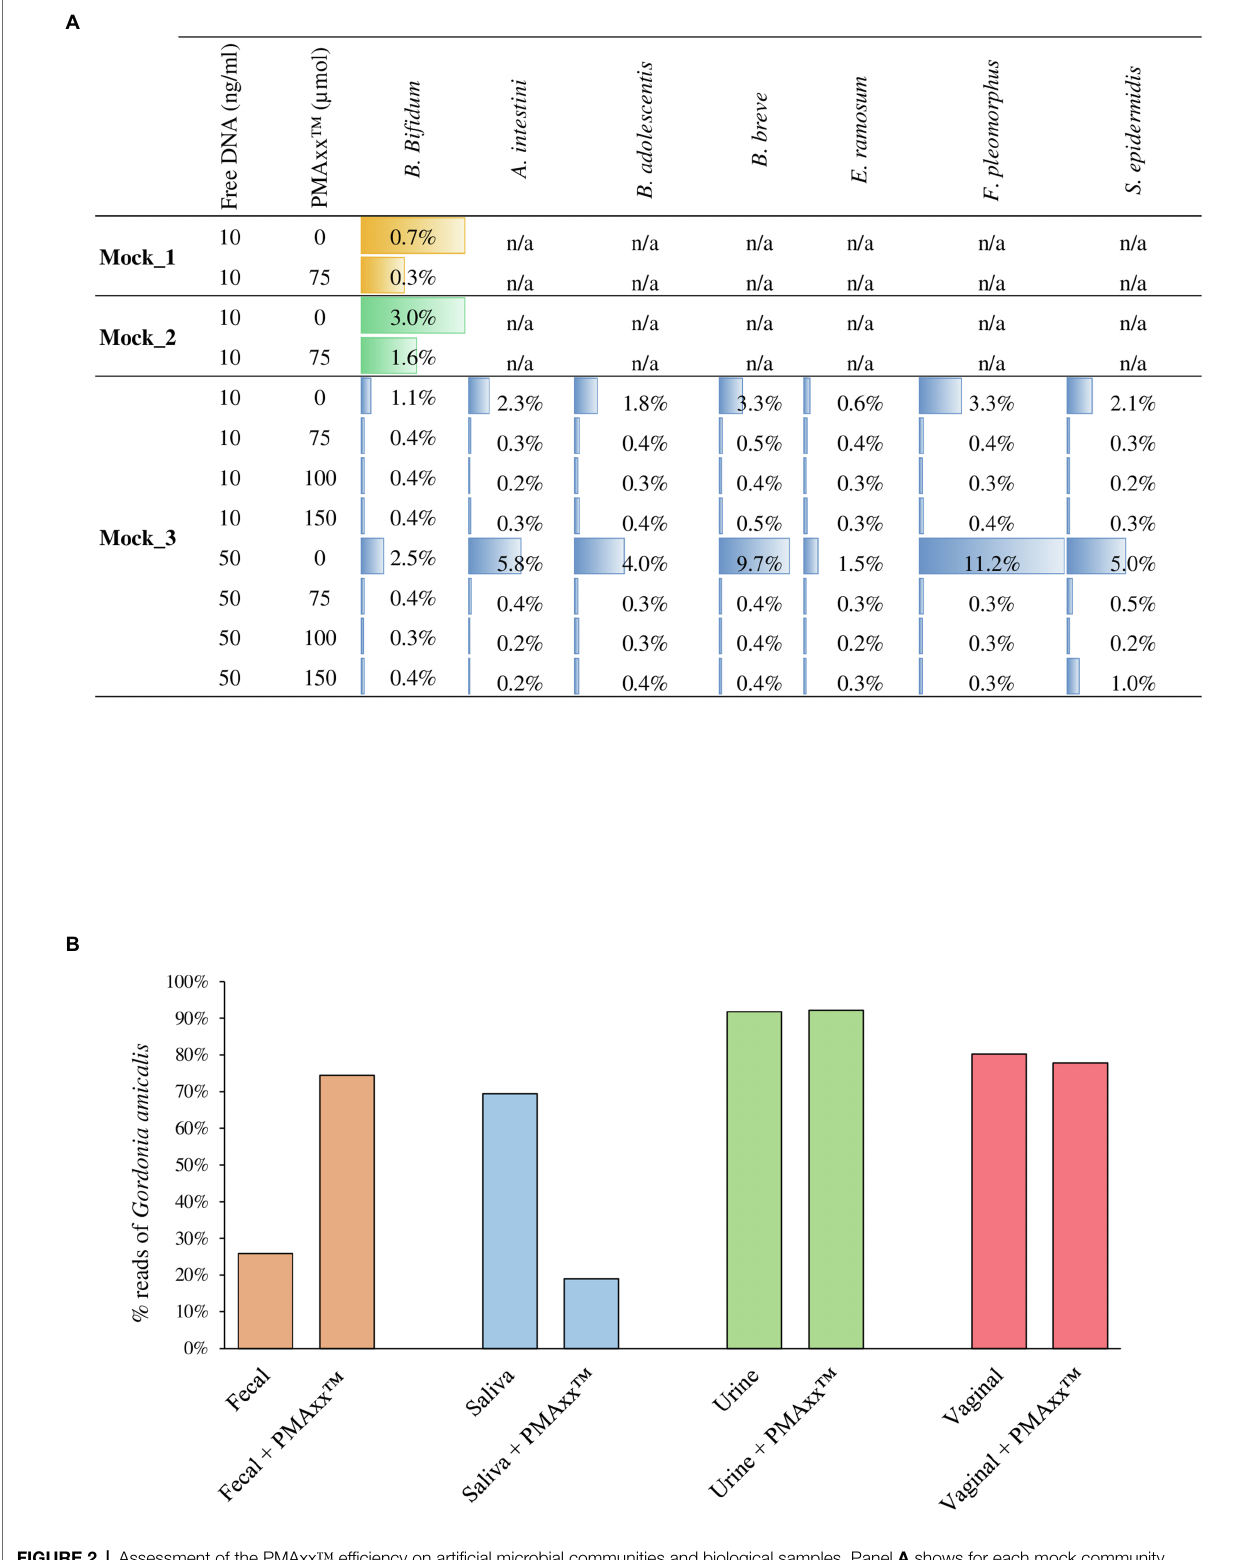
FIGURE 2 | Assessment of the PMAxx ™ efficiency on artificial microbial communities and biological samples. Panel A shows for each mock community performed, the percentage of sequences aligned to the specific added free DNA. Panel B reports the percentage of G. amicalis DSM44461 free DNA in each biological sample, i.e., fecal, saliva, urine, and vaginal, treated or no-treated with PMAxx ™